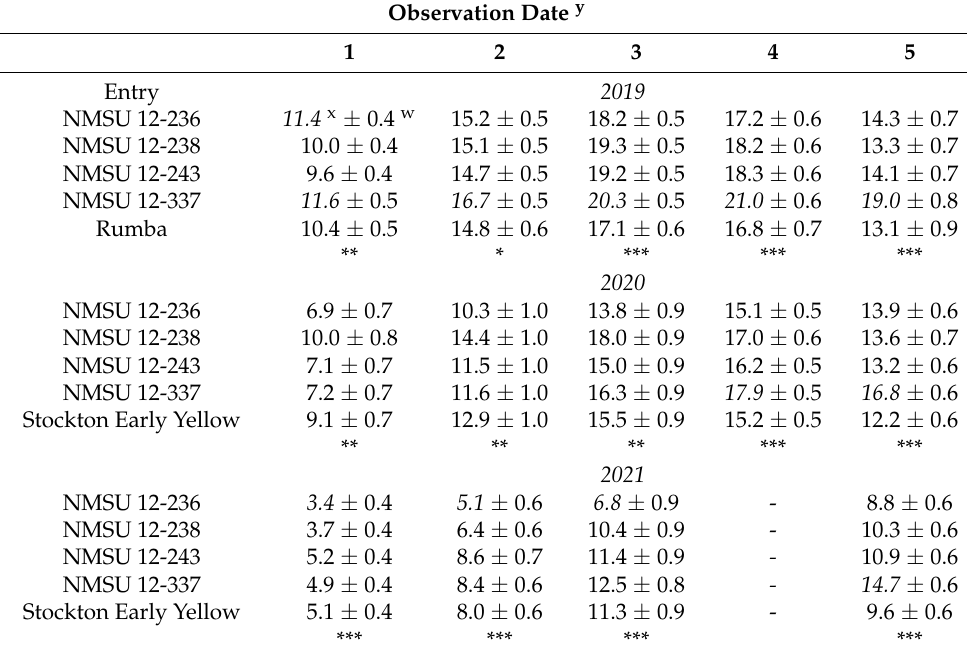
Table 2. Sheath diameter (mm) means measured five times, biweekly, on per plant basis for five onion entries grown at the Fabian Garcia Science Center and Leyendecker Plant Science Research Center, Las Cruces, NM, during the 2019, 2020 and 2021 growing seasons z